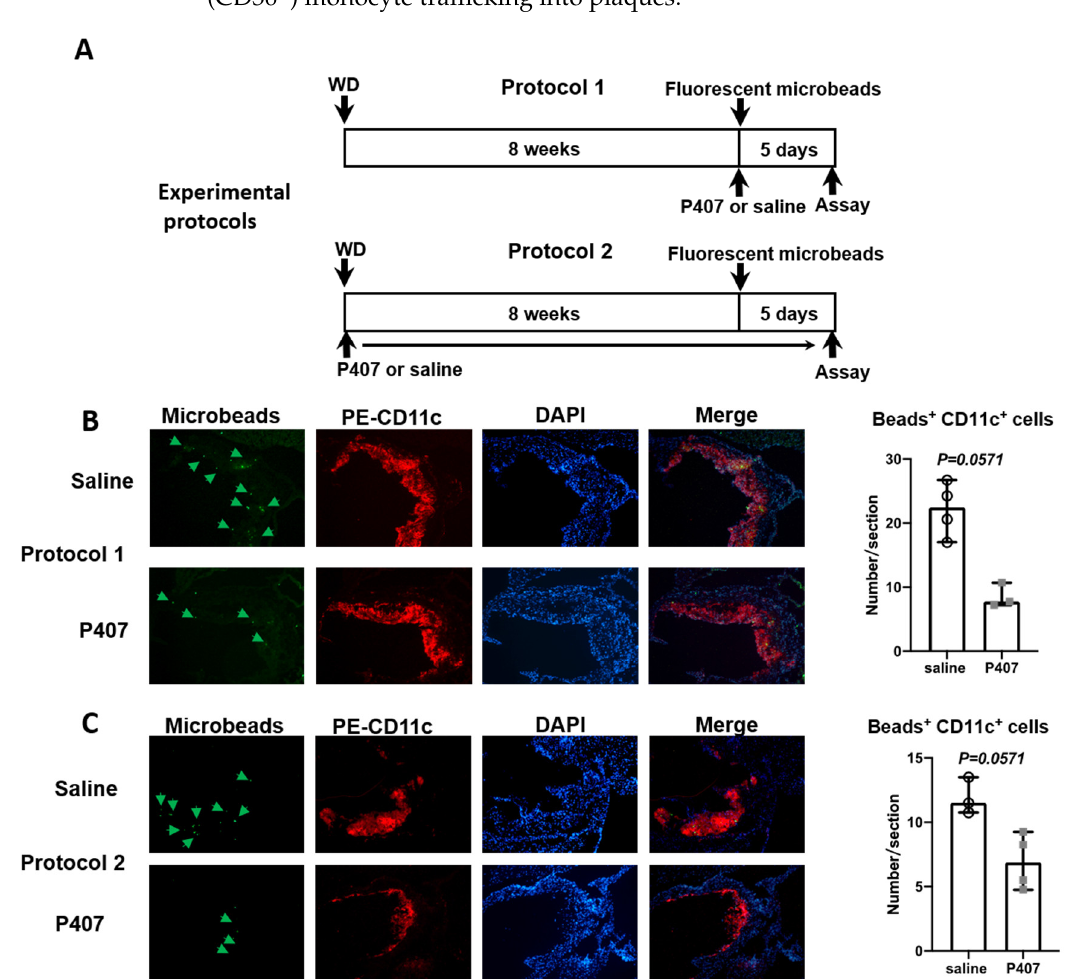
Figure 6. CD11c + (CD36 + ) monocyte infiltration into atherosclerotic plaques. ( A ) Experimental protocols for WD feeding, P407 or saline injection, and injection of fluorescent microbeads (to label CD11c + monocytes) in Ldlr − / − mice. Representative images of aortic root showing infiltration of microbead (green)-labeled CD11c + monocytes into atherosclerotic plaques and staining for CD11c (red), DAPI (blue), and quantitation of labeled CD11c + monocyte infiltration into plaques in protocols ( B ) 1 and ( C ) 2. n = 3–4 mice/group. Data are shown as median with 95% confidence interval and were analyzed by the Mann–Whitney test.